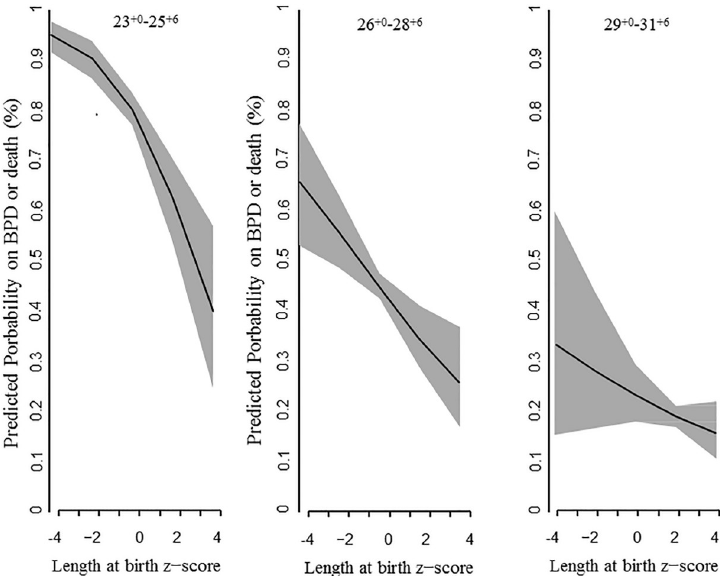
Fig 3. Length at birth z-score for predicting BPD or death by multivariable logistic regression analysis. The regression line and its 95% CI (gray shade) are shown for each gestational age group.